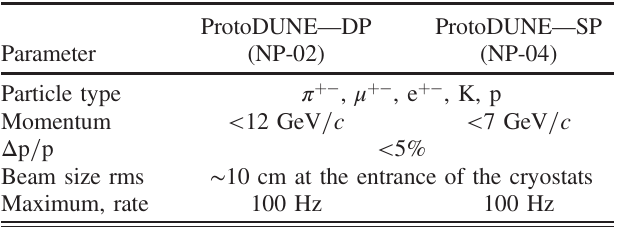
TABLE I. The main beam design parameters as described in the experimental proposals, of ProtoDune — DP (NP-02) and ProtoDune — SP